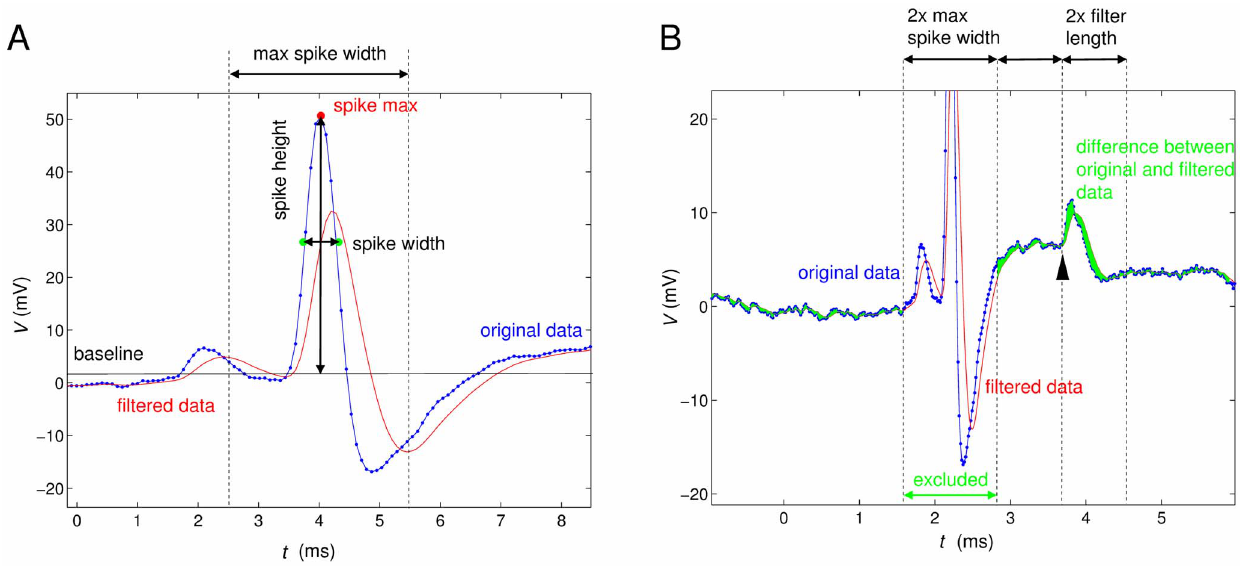
Figure 1. Illustration of the calculation of spike height, spike width and noise amplitude. A) Spike height and width: The blue trace represents the original voltage data with small blue markers indicating the sampling. The red line is the moving average, which is used in spike detection. The black horizontal line represents the baseline value that is calculated by averaging the membrane potential in windows to the left and the right of the spike. The spike height is determined as the difference of the maximal voltage value of the spike and the baseline value. The spike width is measured as the distance of the two closest measurements below the half-height of the spike. B) Short time scale noise amplitude: The difference is taken between the original membrane potential measurement V m and the filtered membrane potential measurement V avg (moving average, see Figure 1A), and its Euclidean norm (normalised by 2 times the filter length + 1) is calculated over two filter lengths, (cid:2) , (1) e.g. the noise level at the arrowhead is calculated from the marked interval of 2 filter r t n z N avg lengths. The areas of 2 maximal spike widths (2 6 3 ms) around every detected spike are excluded from this calculation and the local noise level is undefined in these areas around